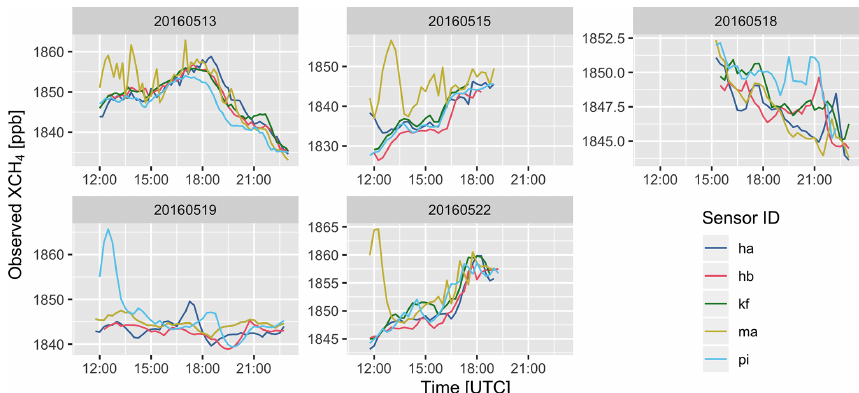
Figure 10. Total column dry mole fraction methane (XCH 4 ) for the five sensors on all 5d of the campaign. The high-frequency signal for sensor ma is due to its close proximity to the South Side Landfill, the largest point source in the city.